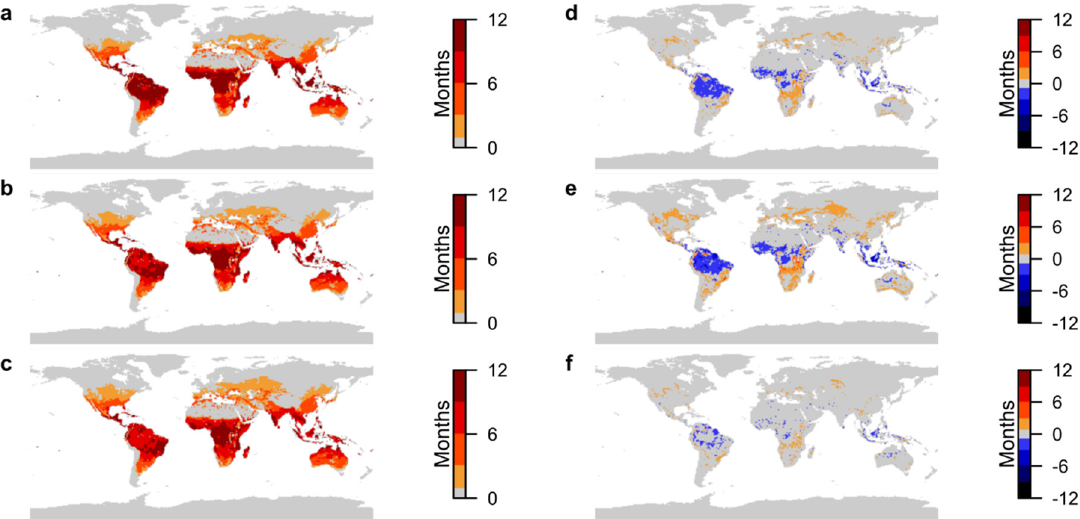
Figure 4. Projections of transmission suitability for all diseases combined. ( a ) Number of months of transmission suitability in present day; ( b ) number of months of transmission suitability in 2050 under SSP1-2.6; ( c ) number of months of transmission suitability in 2050 under SSP5-8.5; ( d ) change in number of months of transmission suitability from present day to 2050 under SSP1-2.6; ( e ) change in number of months of transmission suitability from present day to 2050 under SSP5-8.5; ( f ) difference in number of months of transmission suitability in 2050 between SSP5-8.5 and SSP1-2.6. For ( a – c ), colour-bar scales are set so that increasing intensity of red depicts areas where transmission suitability is marginal (1–3 months), moderate (4–6 months), seasonal (7–9 months) and endemic (10–12 months). For ( d – f ), colour-bar scales are similarly grouped, with increasing intensity of red depicting increases in transmission suitability of 1–3 months, 4–6 months, 7–9 months and 10–12 months, and increasing intensity of blue depicting the equivalent decreases. Only areas where differences are statistically significant at the 95% confidence level are